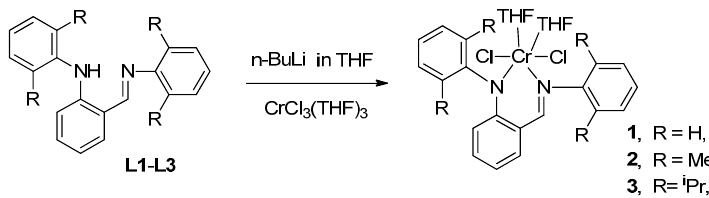
Table 1. Ethylene polymerizations with 1–3